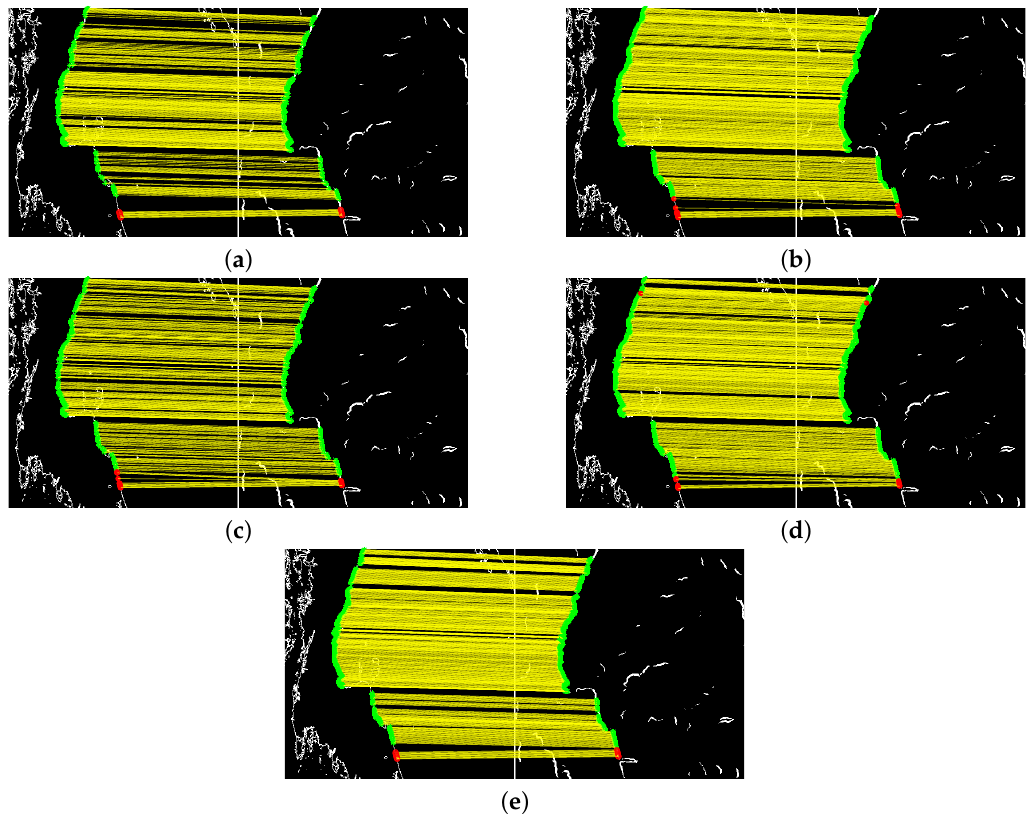
Figure 9. Matching results obtained by five different algorithms. ( a ) GTM. ( b ) RSOC. ( c ) KNN-TAR. ( d ) NCV. ( e )